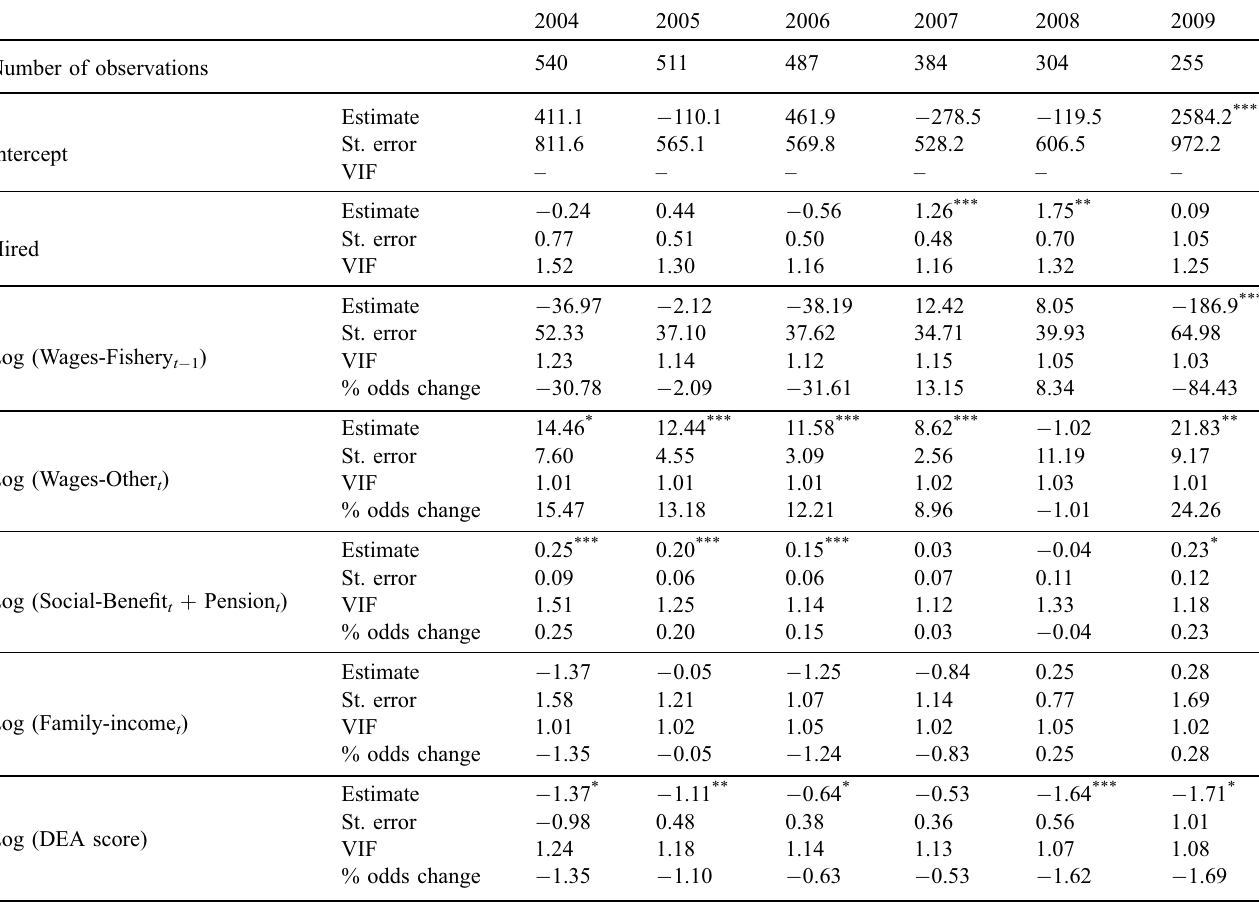
Table 6. Parameter estimates from the logit regression including fi shery wages in year t (cid:2) 1. Standard errors of the parameters and variance in fl ation factors (VIFs) are included. Furthermore, the table displays the % change in probability of leaving the fi shery when the explanatory variable changes by